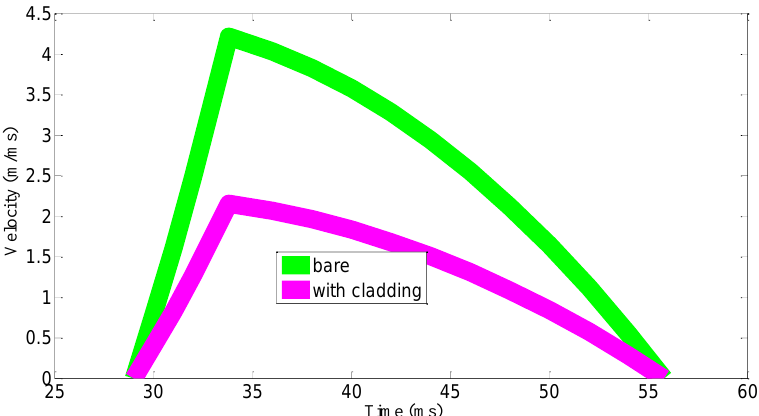
(b): Response of blast load on rear wall along velocity with and without cladding material.